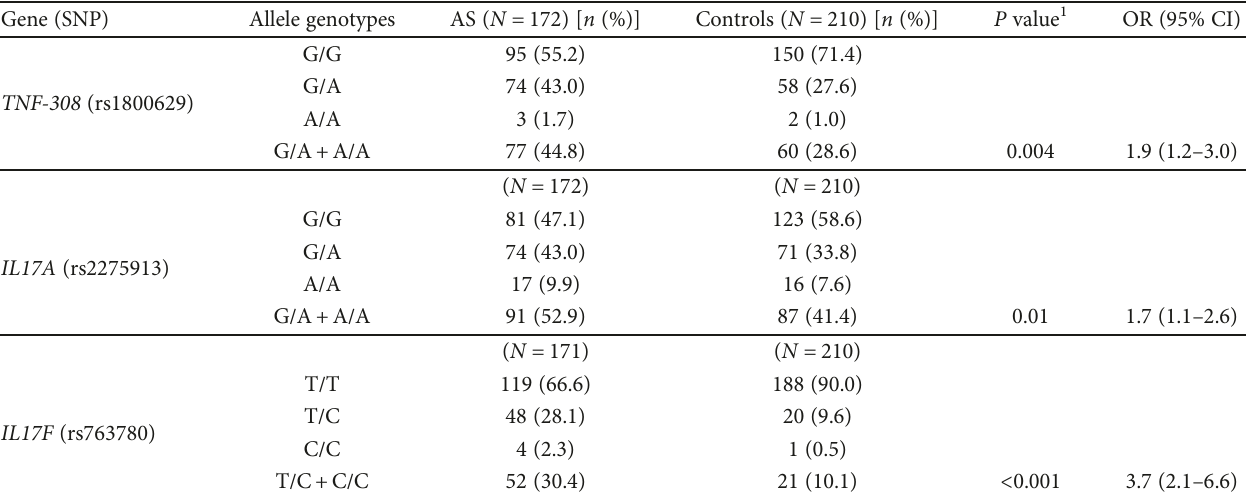
Table 4: Association of TNF-308 , IL17A , and IL17F with the risk of AS, strati fi ed by gender and HLA-B27 marker. Gene (SNP) Allele